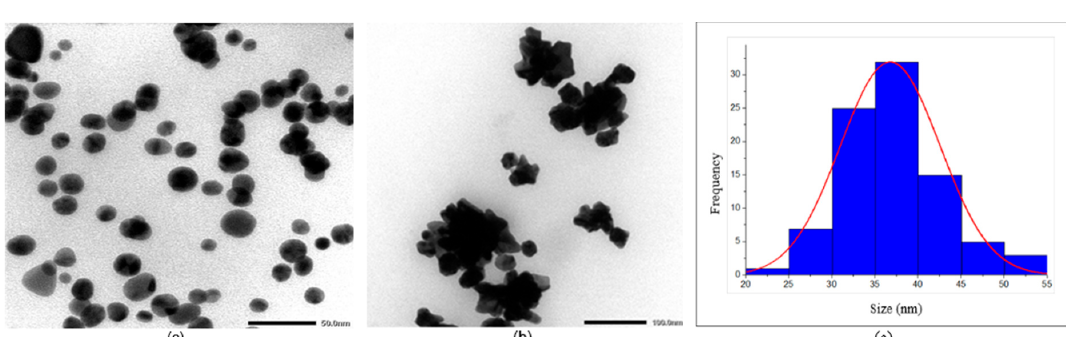
Table 1. UV-Vis results of branched AuNPs synthesized by gelatin with different concentrations of gelatin .